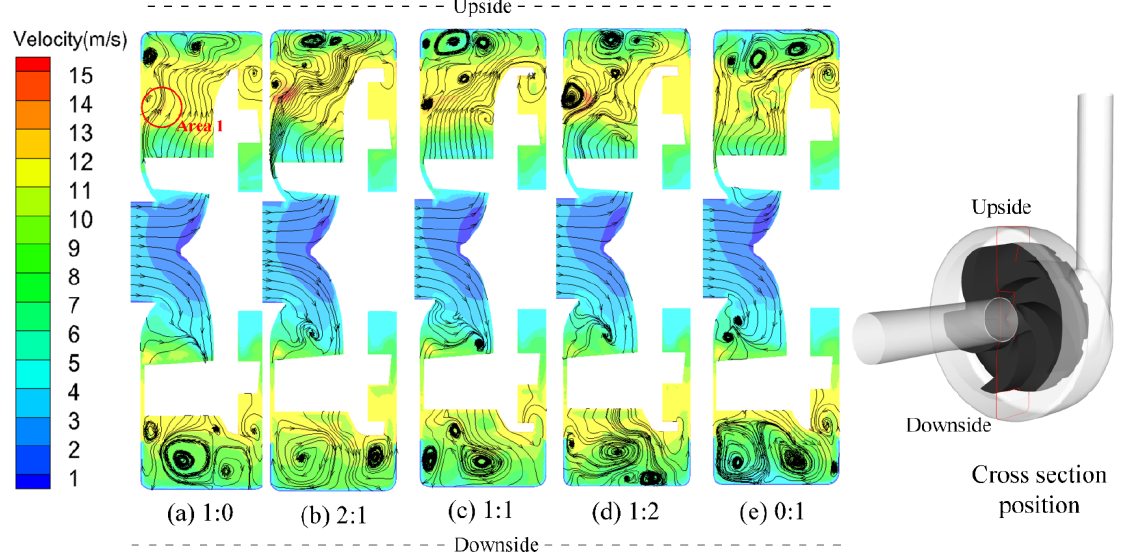
Figure 10. Velocity-streamline distribution of centrifugal pump in the horizontal cross section under different particle ratios.